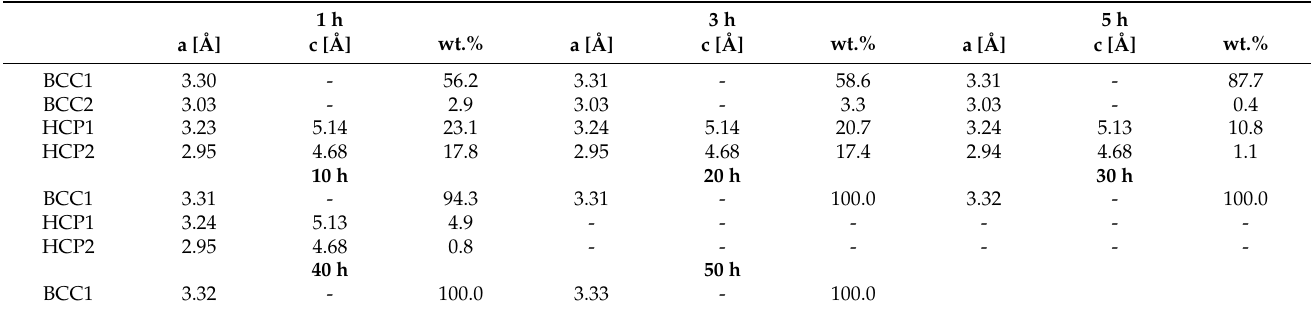
Table 1. Lattice parameters of the mechanically alloyed powders detected by XRD analysis. 1